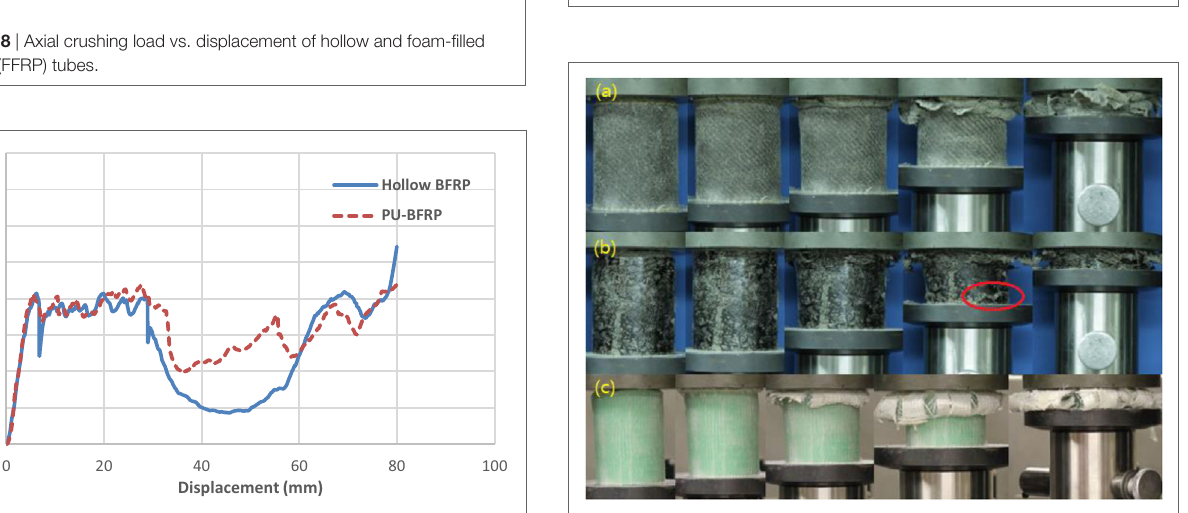
FigUre 10 | Axial crushing load vs. displacement of hollow and foam-filled glass FRP (GFRP) tubes.